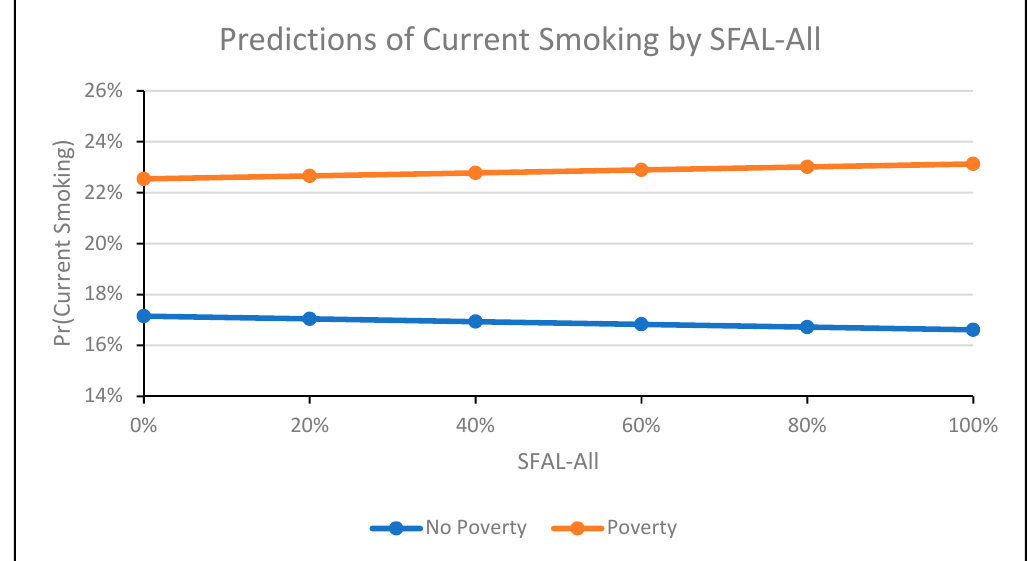
Figure 1. This figure depicts the probability of individual-level adult current smoking in the 1985 − 2015 supplements to the U.S. Current Population Survey by percent of state population covered by workplace, bar, and restaurant smoke-free laws (SFAL-All), stratified by individual poverty status (living < 138% of poverty line versus living ≥ 138% of poverty line). The figure excludes participants with missing values for variables of interest and was produced using the “margins” command in Stata.